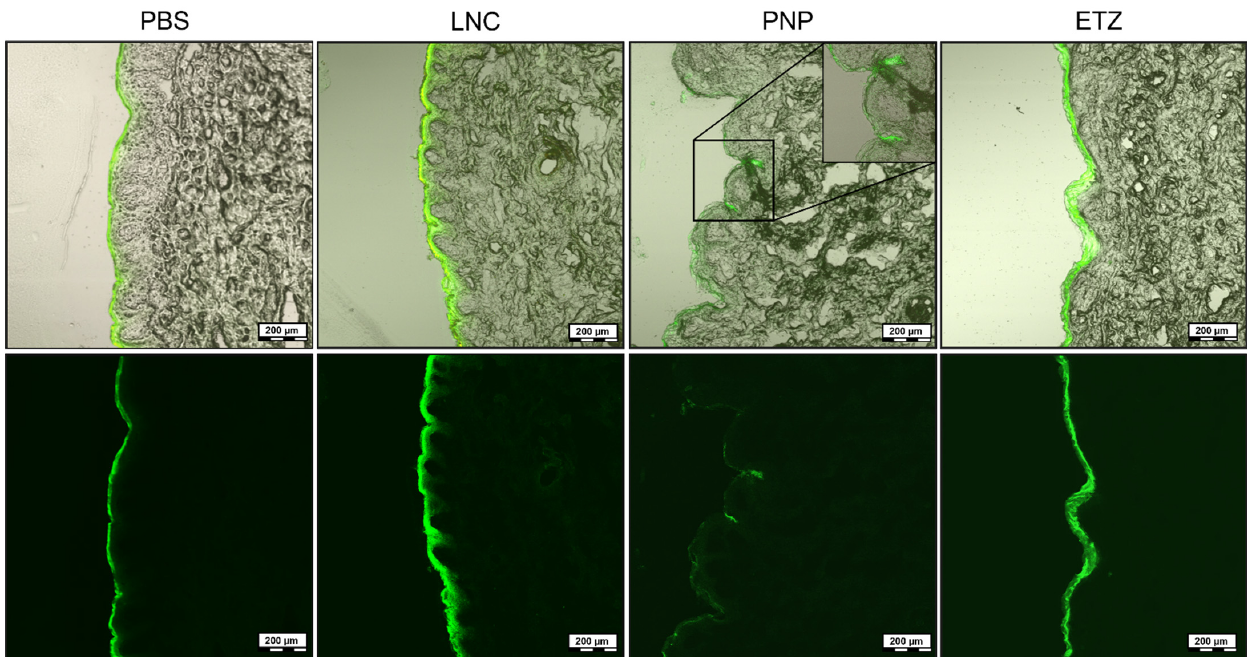
Figure 9. Confocal microscopy of skin treated for 24 h by a suspension of fluorescein sodium suspension in PBS, FNa-labelled lipid nanocapsules (LNC), FNa-labelled PLGA nanoparticles (PNP), and NBD-PC labelled ethosomes (ETZ). The scale bar represents 200 µm.